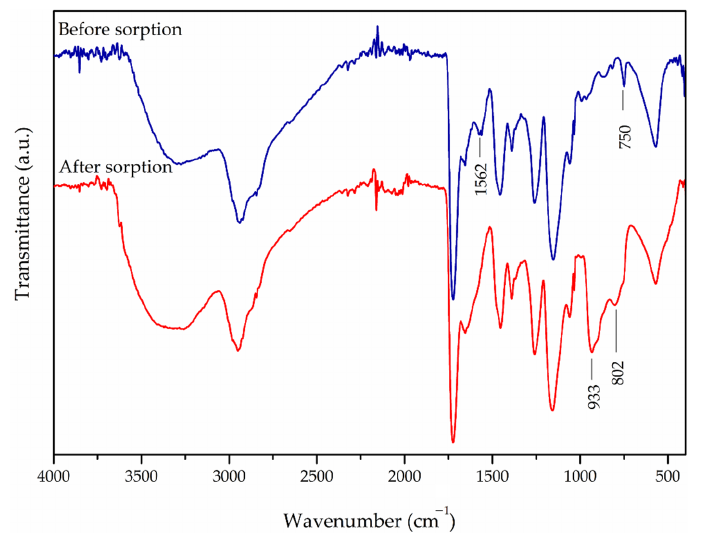
Figure 9. ATR-FTIR spectra of Fe 3 O 4 @APTMS/PGME-deta before and after sorption of chromium.